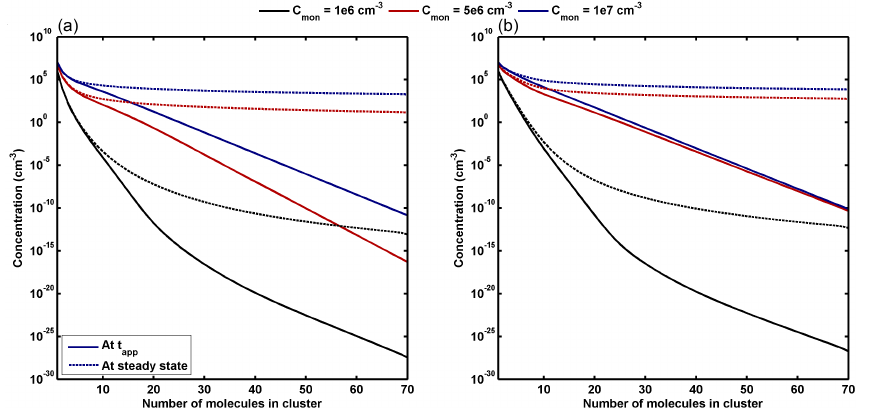
Figure A4. Cluster distribution at the mean appearance time of the two smallest size bins (solid lines) and at the final steady state (dashed lines) when (a) the Gibbs free energy profile has one maximum and no minima (b) the Gibbs free energy profile has an additional negative term corresponding to the stabilization of the smallest clusters. The colors show the steady-state monomer